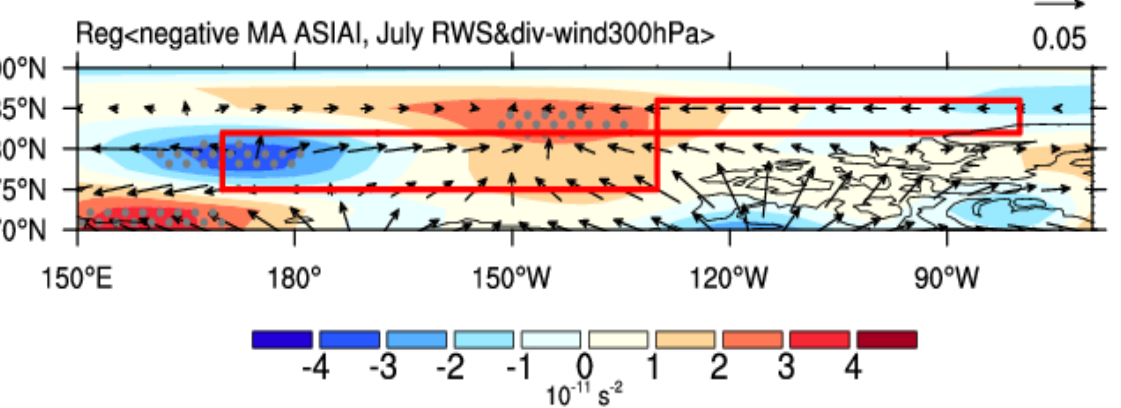
Figure 10. Regression map of July–mean 300 hPa RWS (shading; unit: 10 − 11 s − 2 ) and divergent horizontal wind (vectors; unit: m s − 1 ) onto the normalized negative MA–mean ASIAI for the period 1980–2016. Areas with significant values of RWS exceeding the 90% confidence level are stippled.